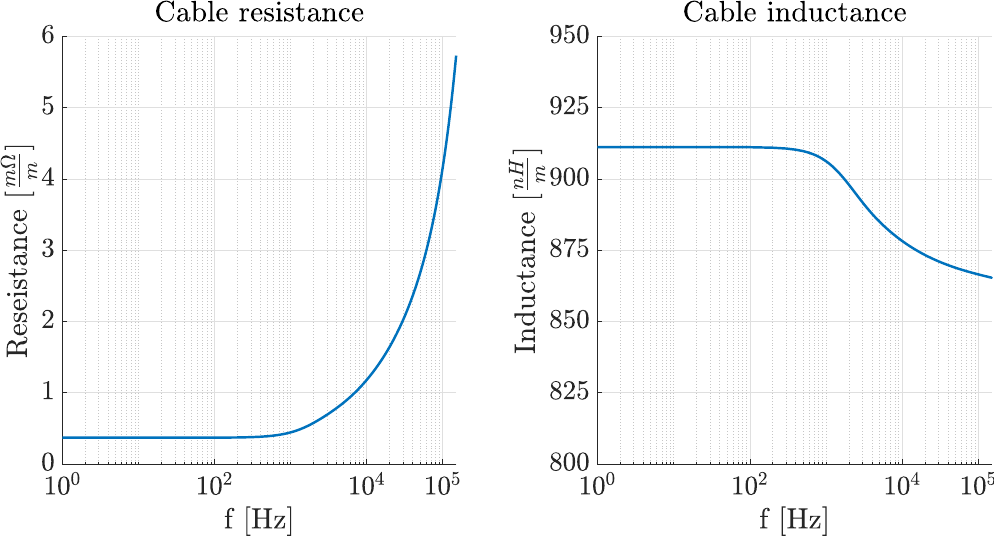
Figure 6. Inductance and resistance of a 50 mm 2 copper cable for EV usage in the frequency range of [10 Hz–150 kHz]; the results are provided using FEMM simulation. Notably, this work focuses on the shield current in the frequency range of [10 Hz–150 kHz]. The further simulations use the provided inductance and resistance values for the HV cables in the specified frequency